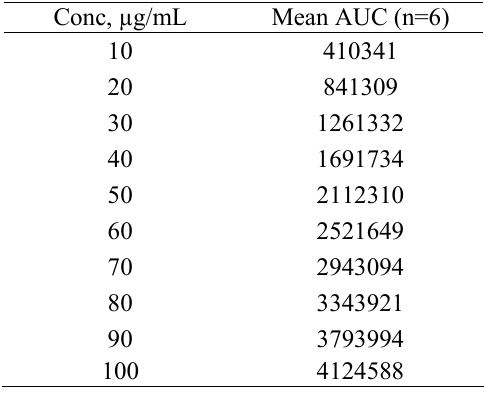
Figure 3. Calibration curve of .montelukast Table 1. Results for construct the calibration